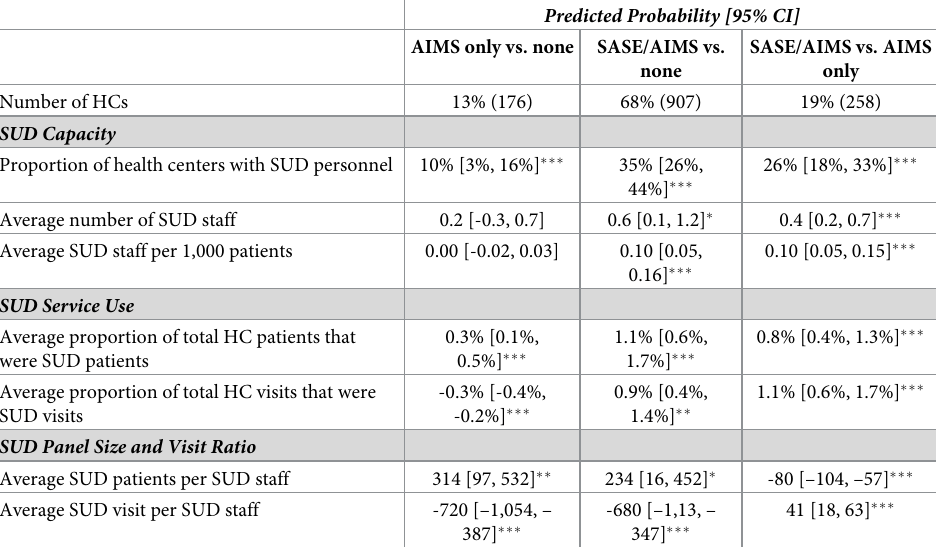
Table 4. Predicted probabilities of Substance Use Disorder (SUD) services by federally-funded health centers in the United States between the year prior to grant distribution (2015) and the last year the grants were distributed (2017), by grantee